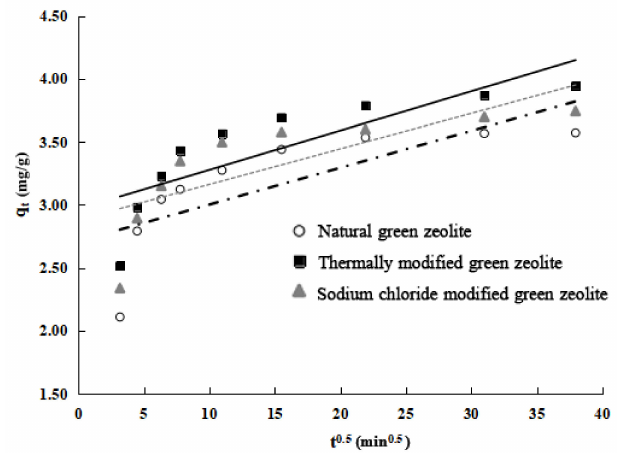
Figure 5. Adsorption curve of three kind of zeolites for q t onto t 0.5